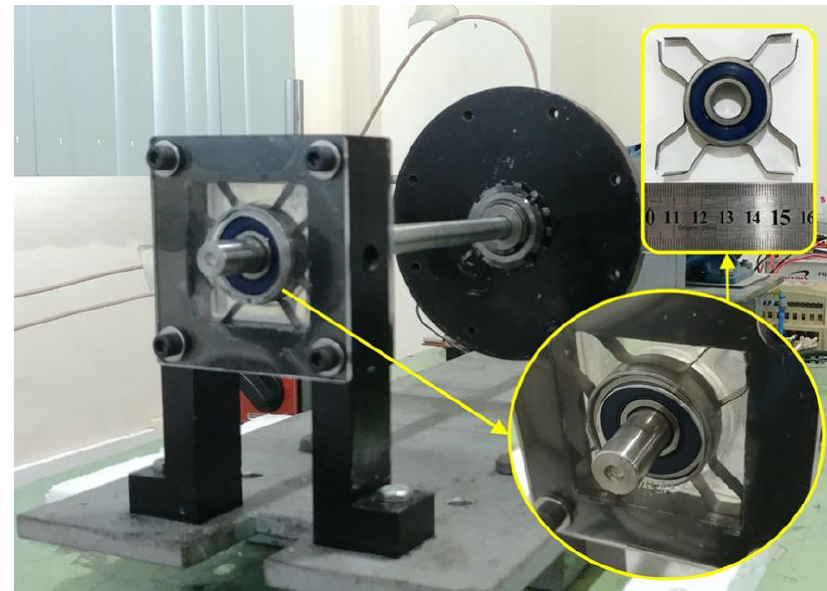
Figure 9. Experimental bench with the M-Shape device.